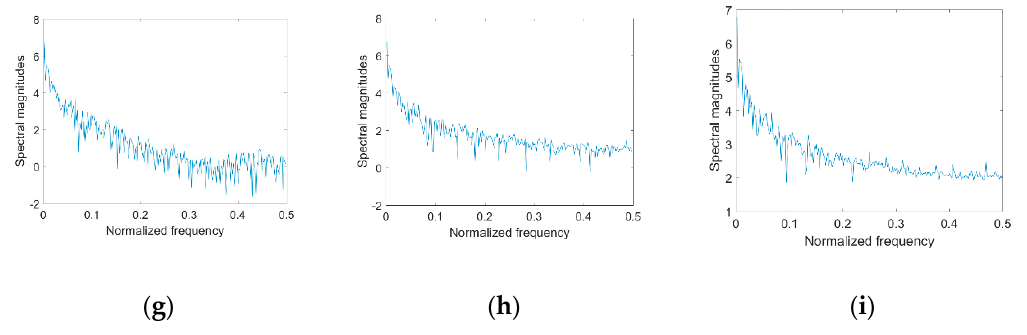
Figure 15. The power spectrum of the image in the solar active region. ( a ) Original image; ( b ) noise image; ( c ) WAFT; ( d ) UTV; ( e )VSNR; ( f ) ASSTV; ( g ) SILR; ( h ) ℓ (cid:2868) sparse; ( i ) LRSUTV.